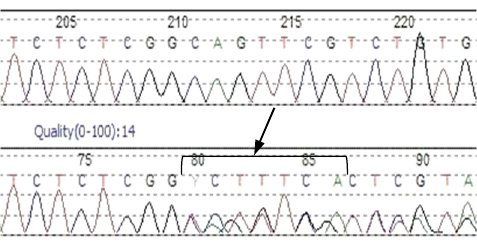
Figure 3. Sanger sequencing chromatogram confirms a heterozygous c.373_379delCAGTTCG variant in the exon 4 of the LDLR gene. Table 4. Lipid concentration values of described siblings and their parents.